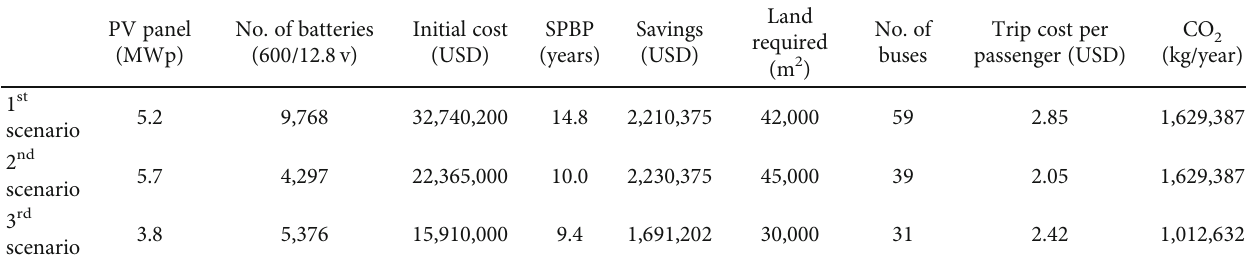
Table 3: Comparison of the proposed